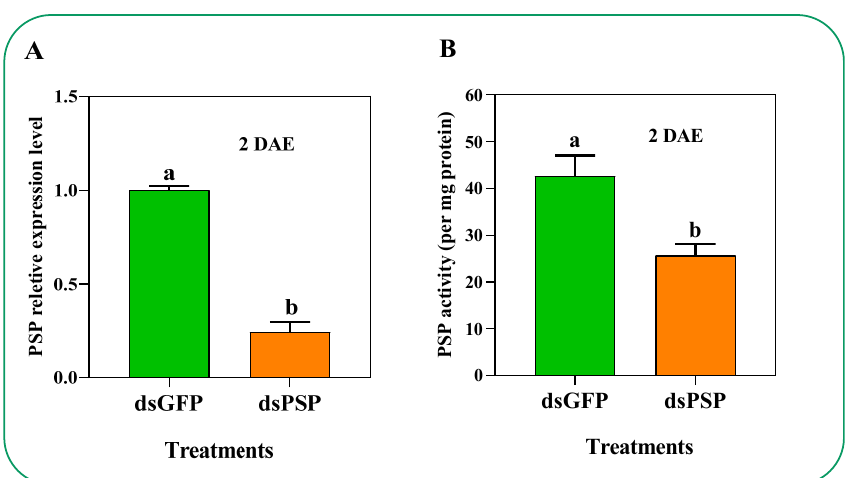
Figure 5. Temporal and development variations of PSP expression in the mentioned life stages. ( A ) represents the PSP expression in developmental stages, 1A represents one day after emergence (one day old), and 2A (two days old), whereas ( B ) represents the expression in selected segments and tissues. Histogram bars indicate expression, and error bars show means ± SEM. Bars annotat- ed with different lowercase letters are statistically significant at p < 0.05 (Tukey test), and DAE is after emergence days.